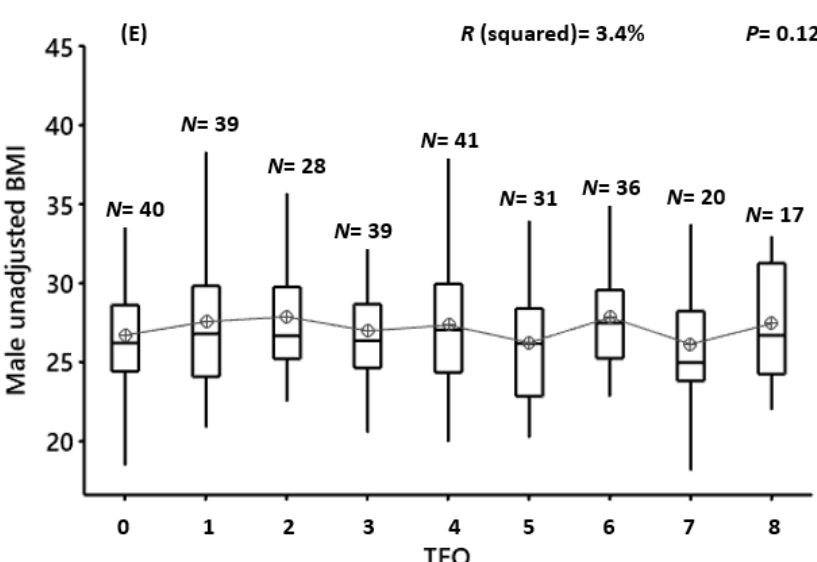
Figure 3. Male unadjusted BMI vs. the frequency of food outlet usage for 7-consecutive days. ( A ) FSR = full-service restaurant, ( B ) FFR = fast-food restaurant, ( C ) delivery, ( D ) take-away and ( E ) TFOs = total food outlets, N = number of participants in each group. Results of the ANOVA are shown. Significance is where p < 0.01 (after Bonferroni correction).